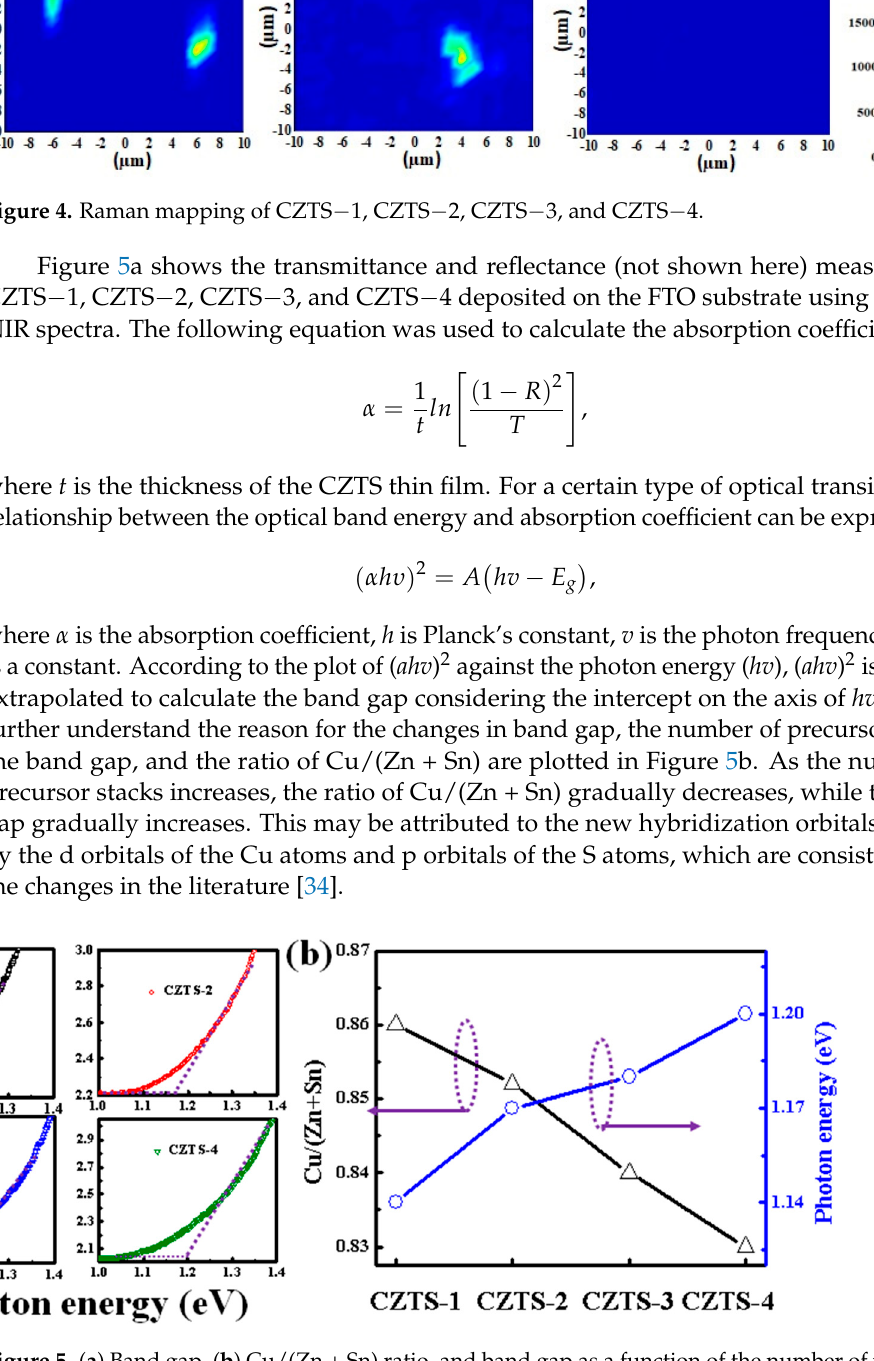
Figure 5. ( a ) Band gap, ( b ) Cu/(Zn + Sn) ratio, and band gap as a function of the number of precursor stacks of CZTS − 1, CZTS − 2, CZTS − 3, and CZTS − 4. To further understand the distribution of each element inside the CZTS thin film, SIMS measurements were carried out for CZTS − 1, CZTS − 2, CZTS − 3, and CZTS − 4, as and FTO. The elemental distribution in the CZTS − 1 thin film absorber layer was not uniform. However, as the number of precursor stacks increases, the elemental distribu- tion inside the CZTS thin films becomes more uniform. Figure 6. SIMS measurement results of CZTS − 1, CZTS − 2, CZTS − 3, and CZTS − 4.